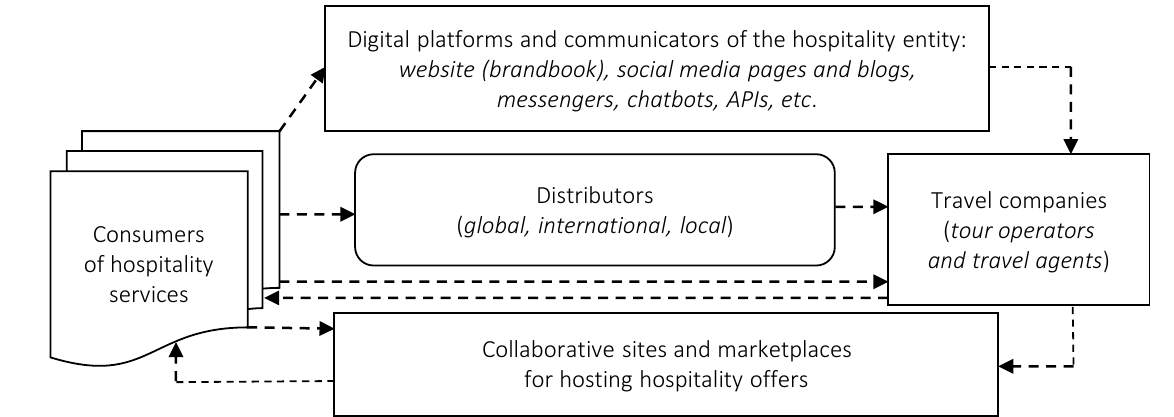
Figure 4. Fulfillment of digital technologies in the distribution system of hospitality services